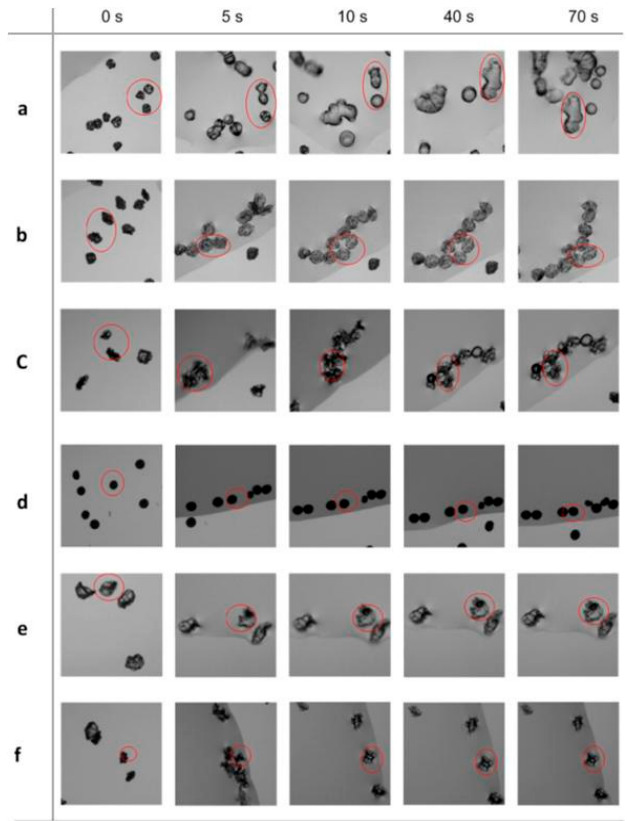
Figure 6. Time-lapse tracking photographs of swelling behaviors in simulate gastric solutions of the microparticles obtained at a drying temperature of 155 °C with an ethanol/water mixed solvent of 1:4 ( a ); 1:1 ( b ); and 4:1 ( c ); volume ratio, and those obtained with an ethanol/water solvent of 4:1 volume ratio at a drying temperature of 95 ( d ); 100 ( e ); and 205 °C ( f ), respectively. A set of the same microparticles in each row was enclosed in red cycles to clearly show their swelling changes with time.